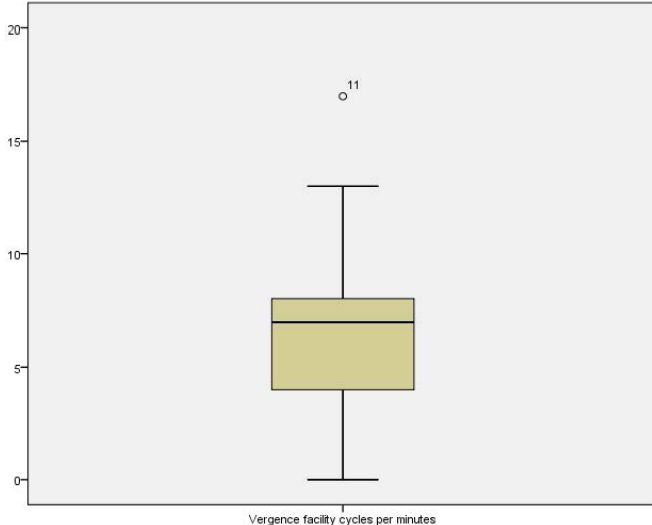
Figure 4 Distribution of vergence facilities